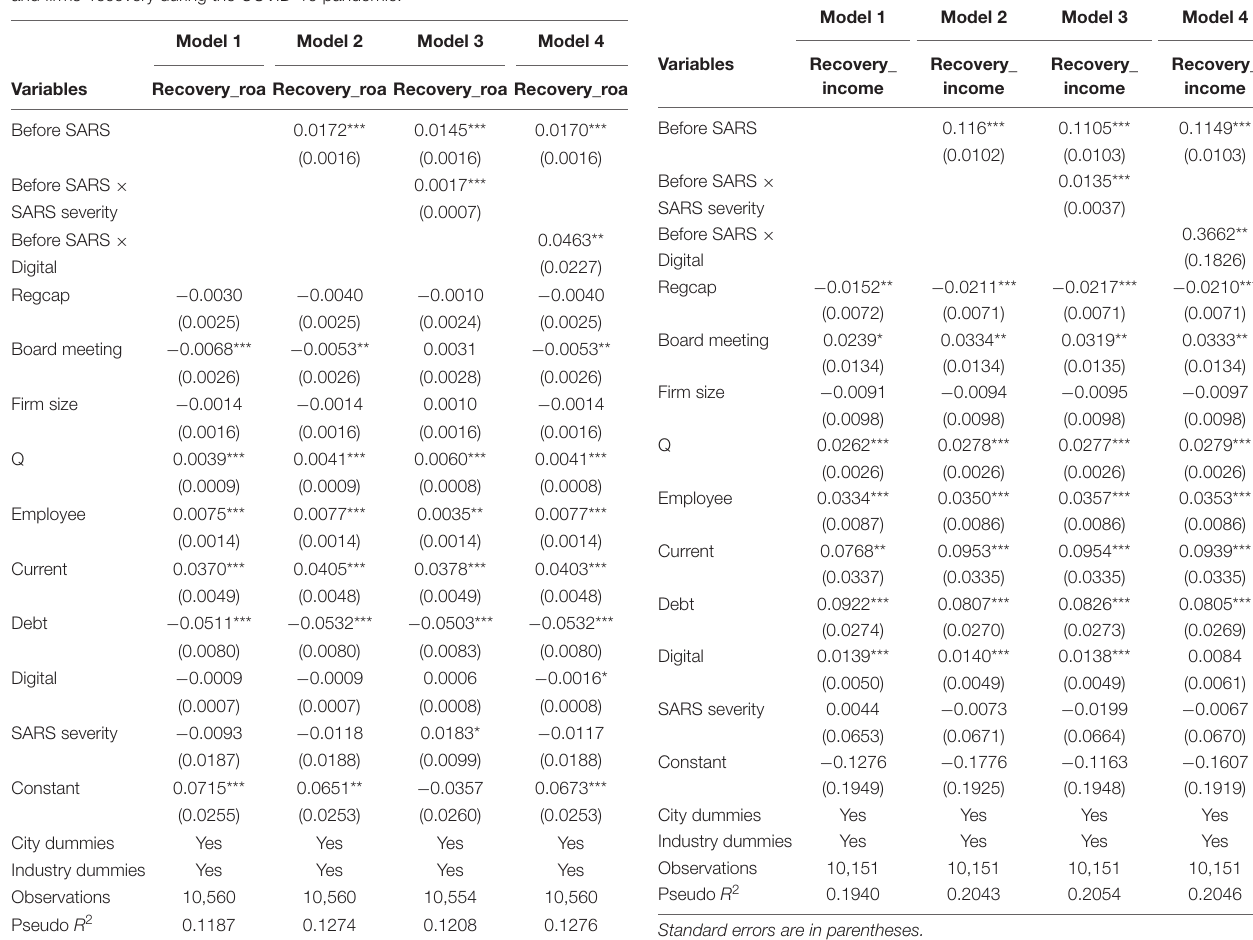
TABLE 3 | OLS regression results of the relationship between SARS imprinting and firms’ recovery during the COVID-19 pandemic.